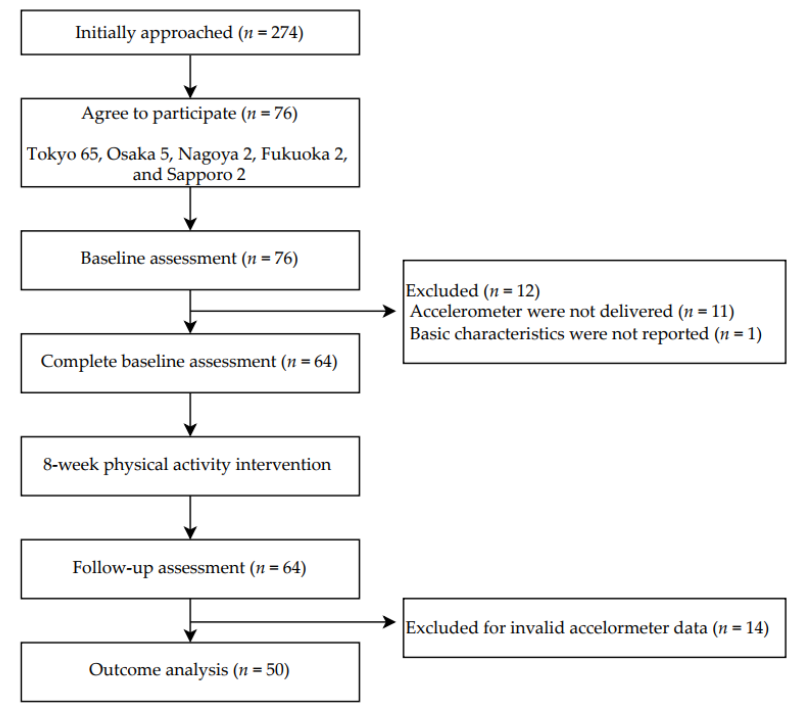
Figure 2. Participant flowchart. Table 1. Characteristics of participants at baseline. Characteristic